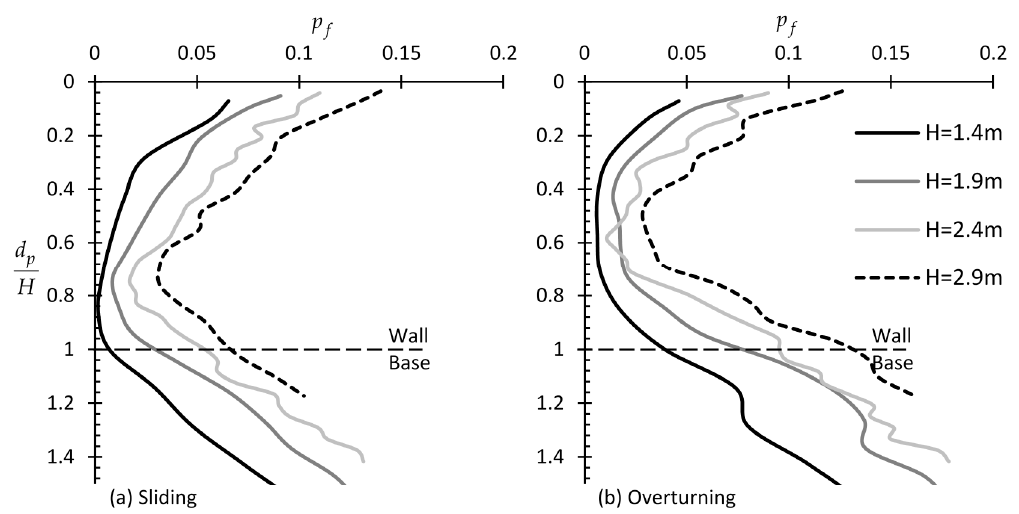
Figure 6. p f − d p / H example curves for x / H = 0.5, θ = 20 m and for di ff erent wall heights, H , for the ( a ) sliding and ( b ) overturning modes of failure.